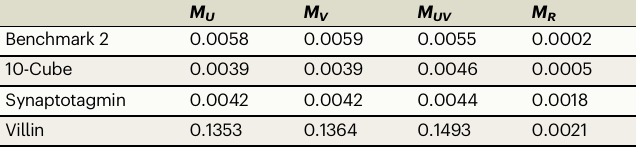
Table 1 | Post-training independence validation